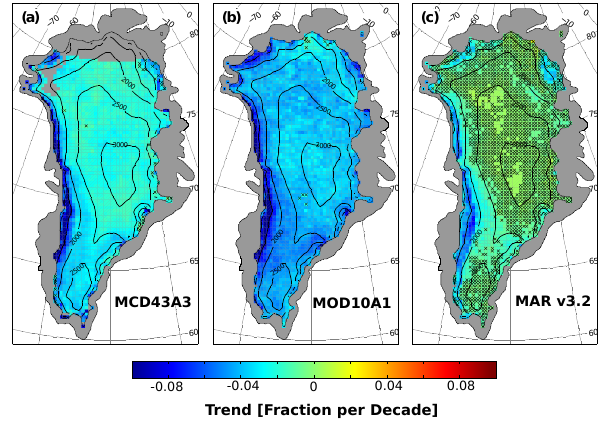
Figure 13. JJA mean albedo trends (2000–2013) in units of frac- tion per decade for (a) MCD43A3 BSA SW albedo, (b) MOD10A1 albedo, and (c) MAR clear-sky albedo. Grid boxes where trends are not significant at the 95% confidence level are marked with a black “x”.